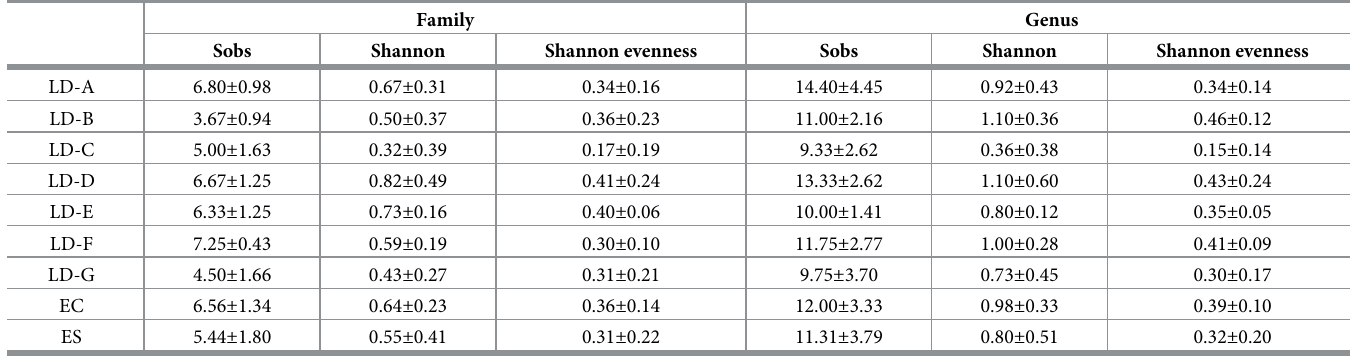
Table 3. Alpha diversity